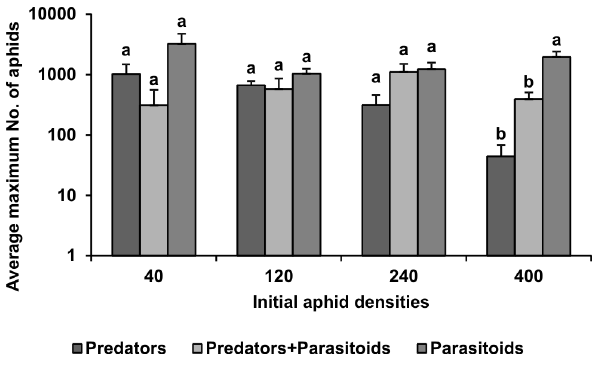
Figure 3. Average ( ± SE) maximum number of aphids recorded in each treatment. For each of the initial numbers of aphids used (40, 120, 240, 400 - indicated on the horizontal axis) different letters at the tops of the columns indicate significant differences between the means recorded in the different sub-treatments.